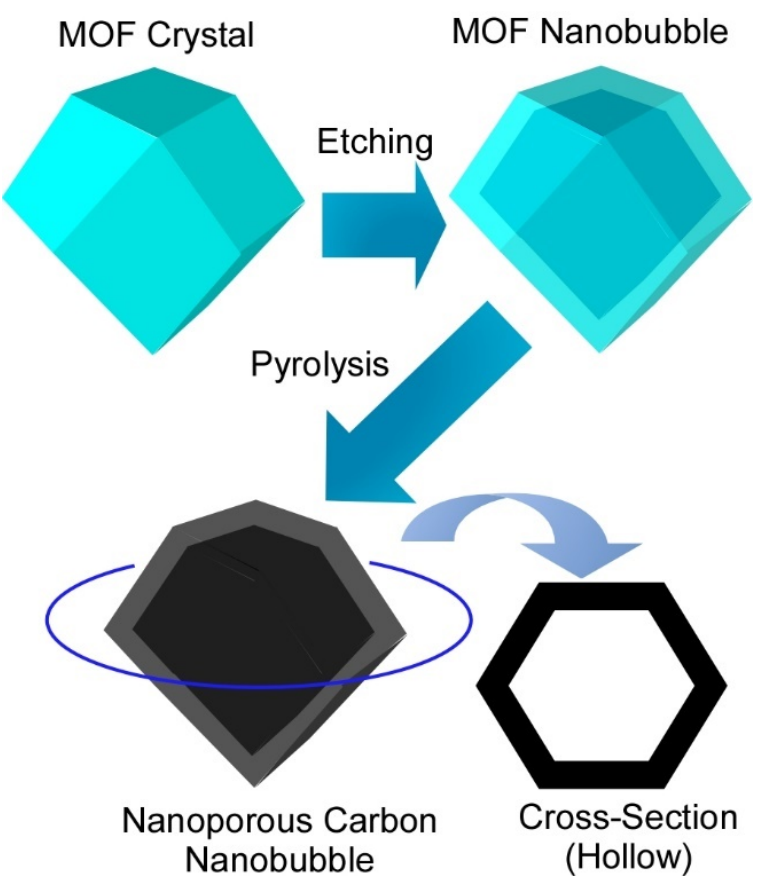
Figure 18. Nanoarchitectonics approach to fabricate hollow MOF nanobubbles and their carbonized materials by combined processes of MOF coordination self-assembly, site-selective etching, and calcination.